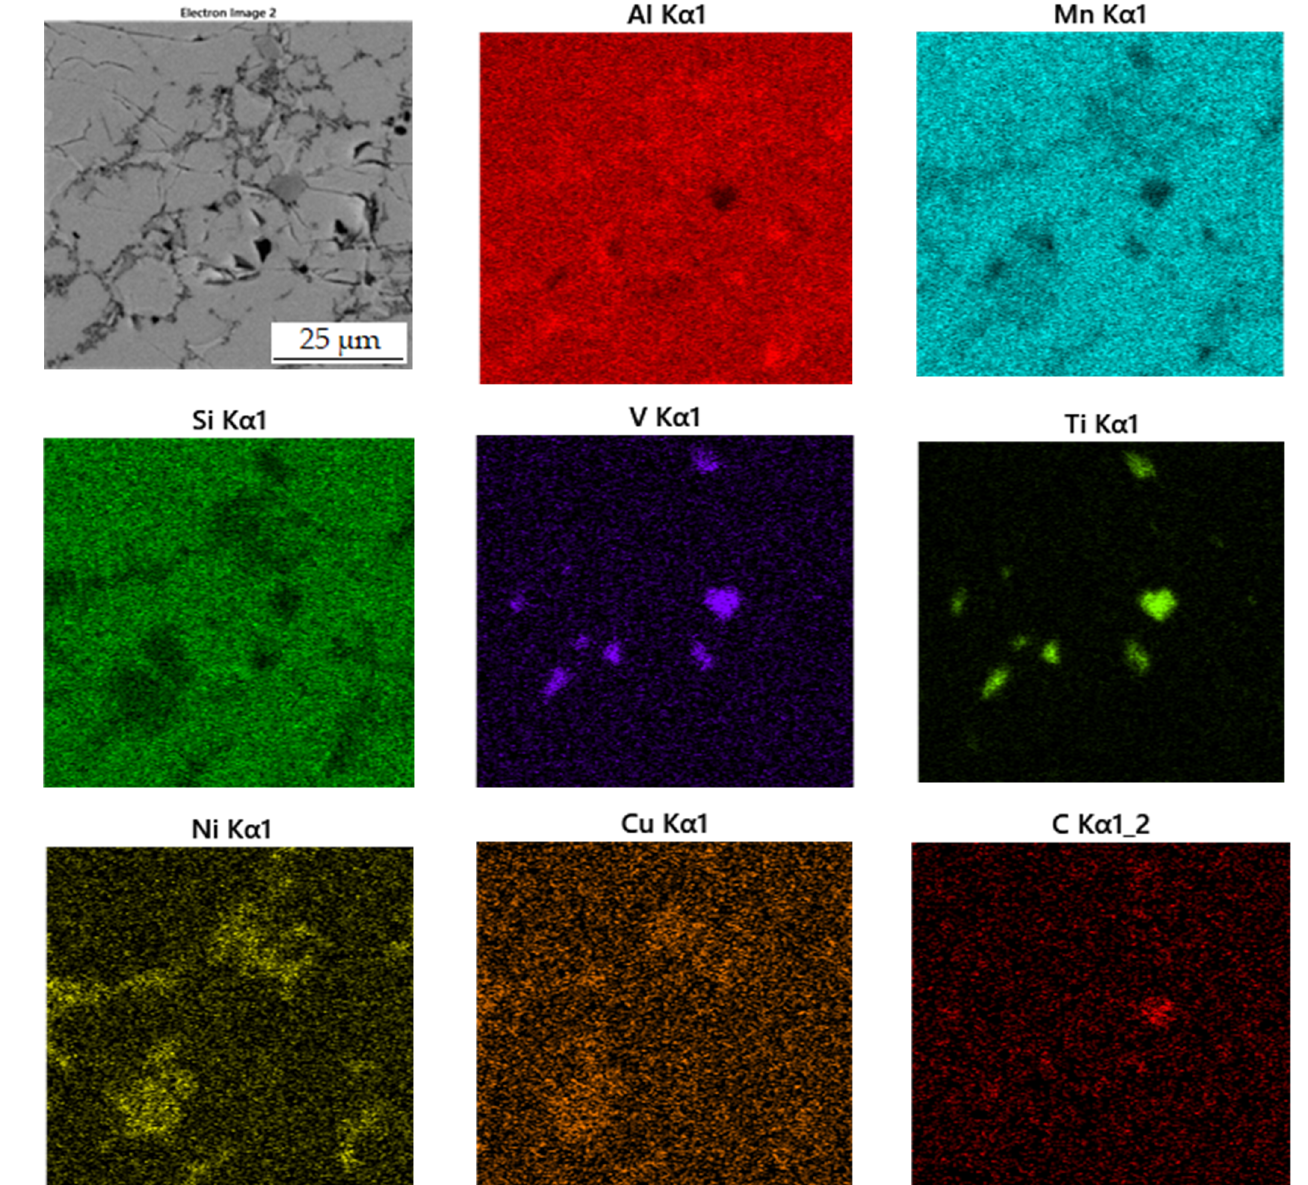
Figure 9. EDS map of the distribution of the elements in sample sintered at 900 °C.